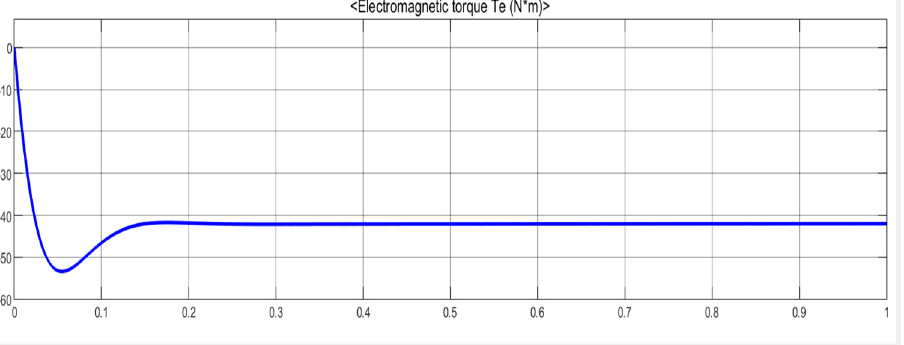
Figure 9. Line current I a.